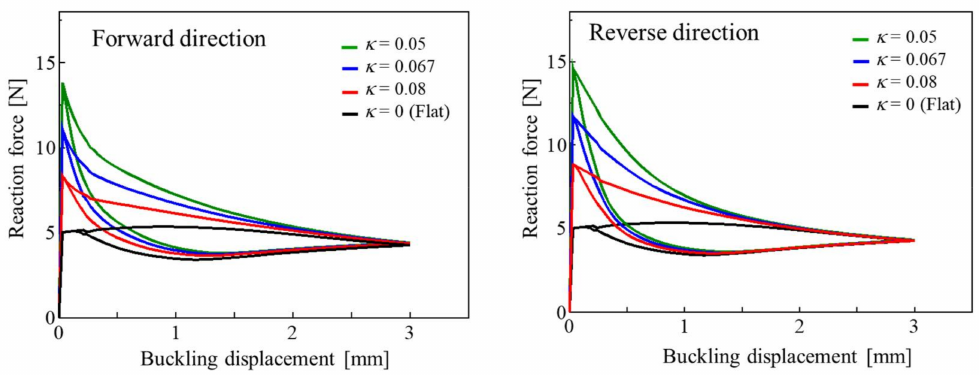
Figure 9. The numerically obtained relationships between the reaction force and buckling displace- ment of the flat and convex tape-shaped SMA elements in each buckling